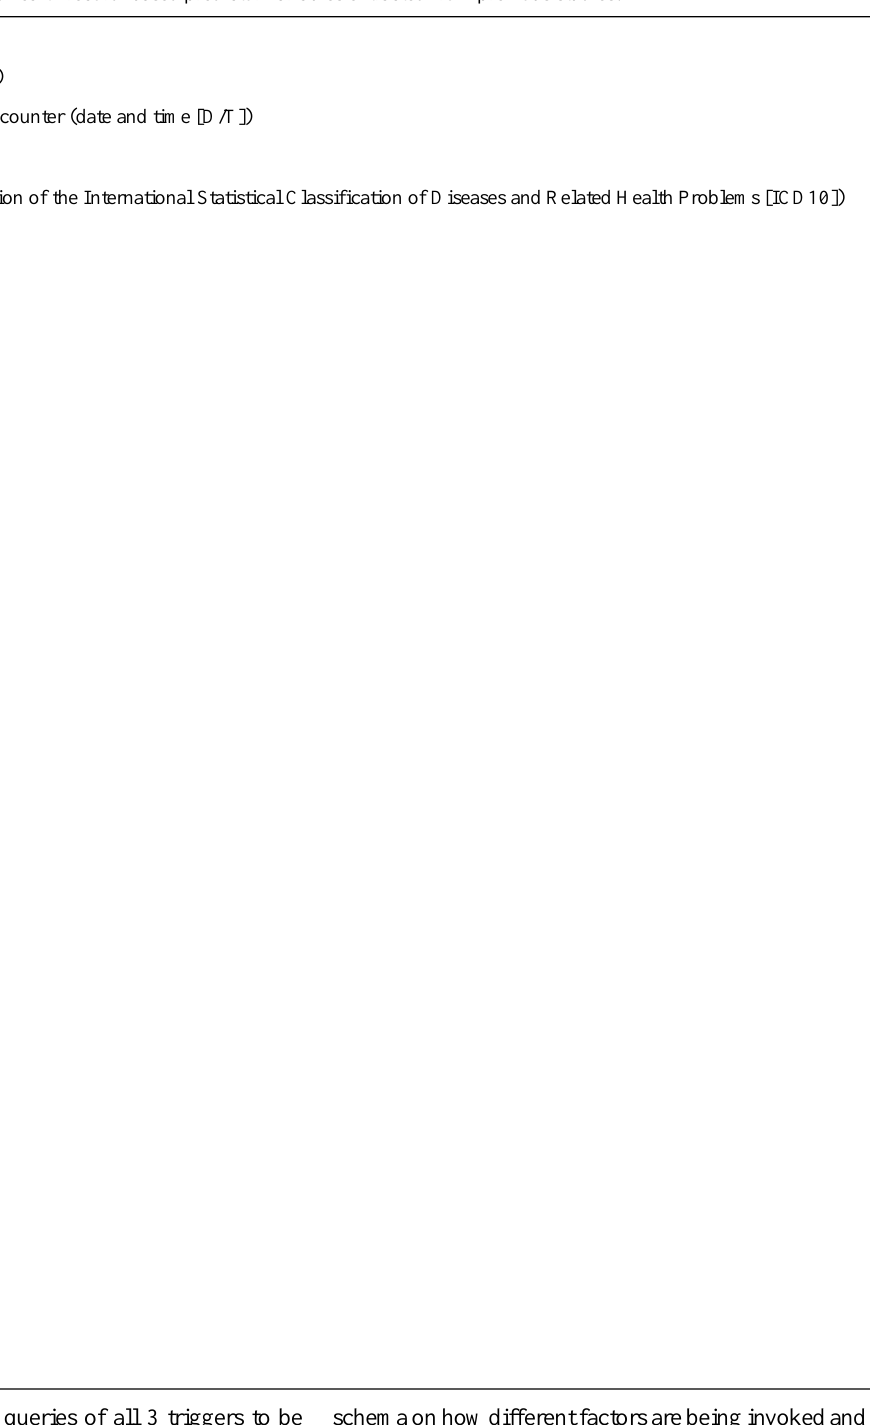
Textbox 2. List of potential electronic health record–based predictor variables extracted from previous